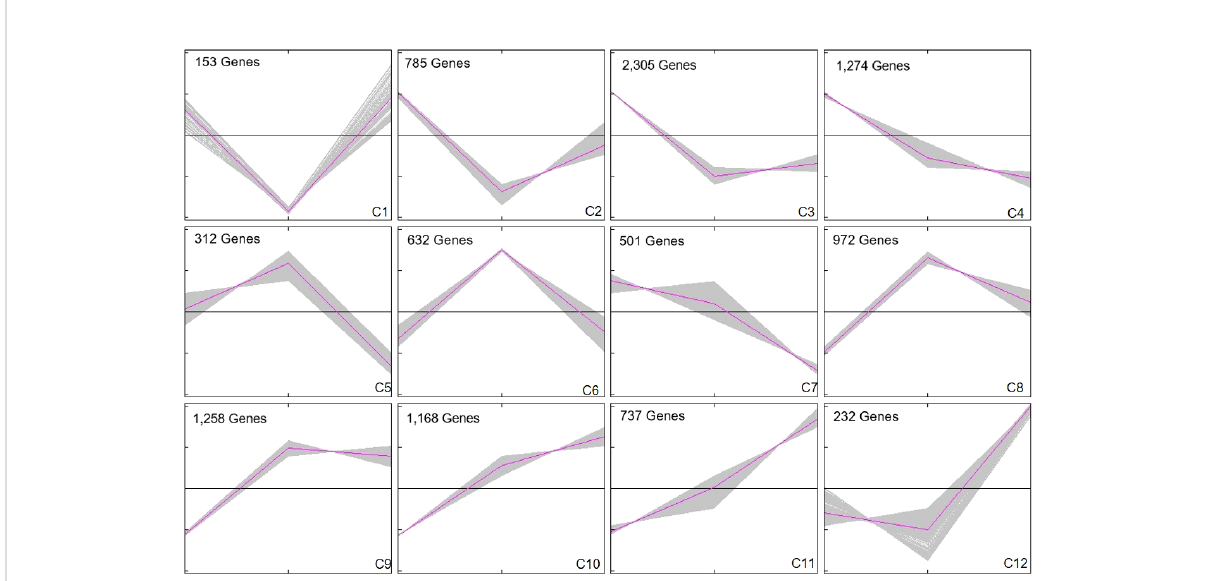
FIGURE 4 Cluster analysis of DEGs. DEGs were clustered and displayed in line chart using Mev. Twelve clusters were grouped. X-axis represents the time points during chilling stress including SP, T15, and T30. Y-axis represents normalized value of the DEGs expression level. The middle black line in each cluster is the zero line and the red line indicates the average expression level. The number in the upper left corner represents the number of DEGs in each